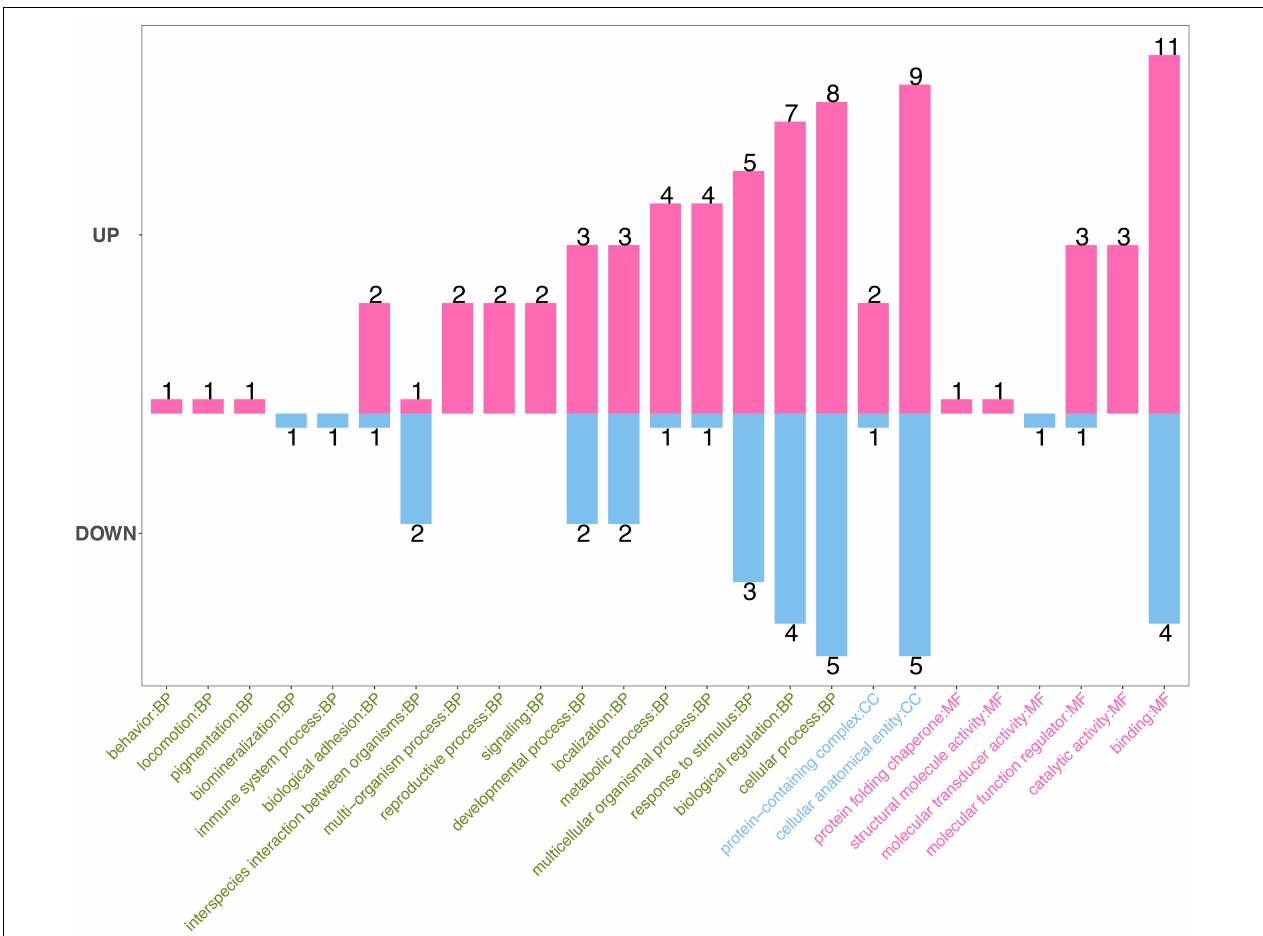
FIGURE 3 | Gene Ontology (GO) enrichment analysis of differential proteins. GO enrichment analysis showed that the annotations of the differentially expressed proteins cover biological process (green), molecular function (red), and cellular component (blue). The numbers on the top of bars represent the number of annotations of the differentially expressed